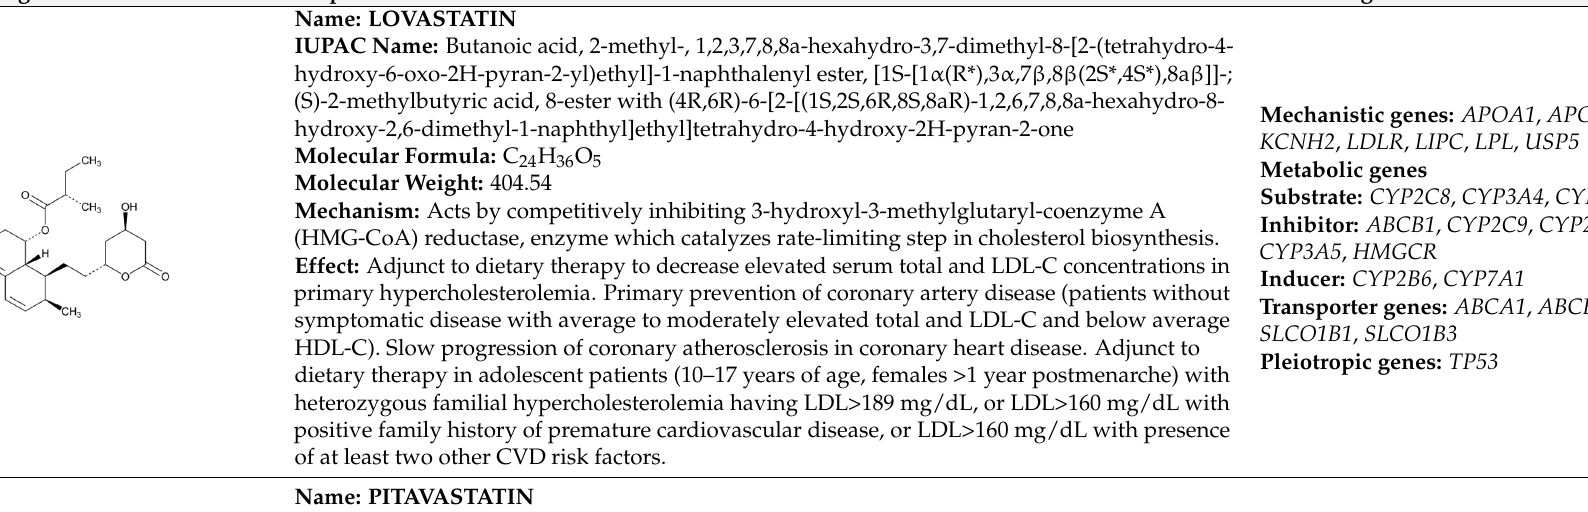
Table 2. Cont. Lipid-Modifying